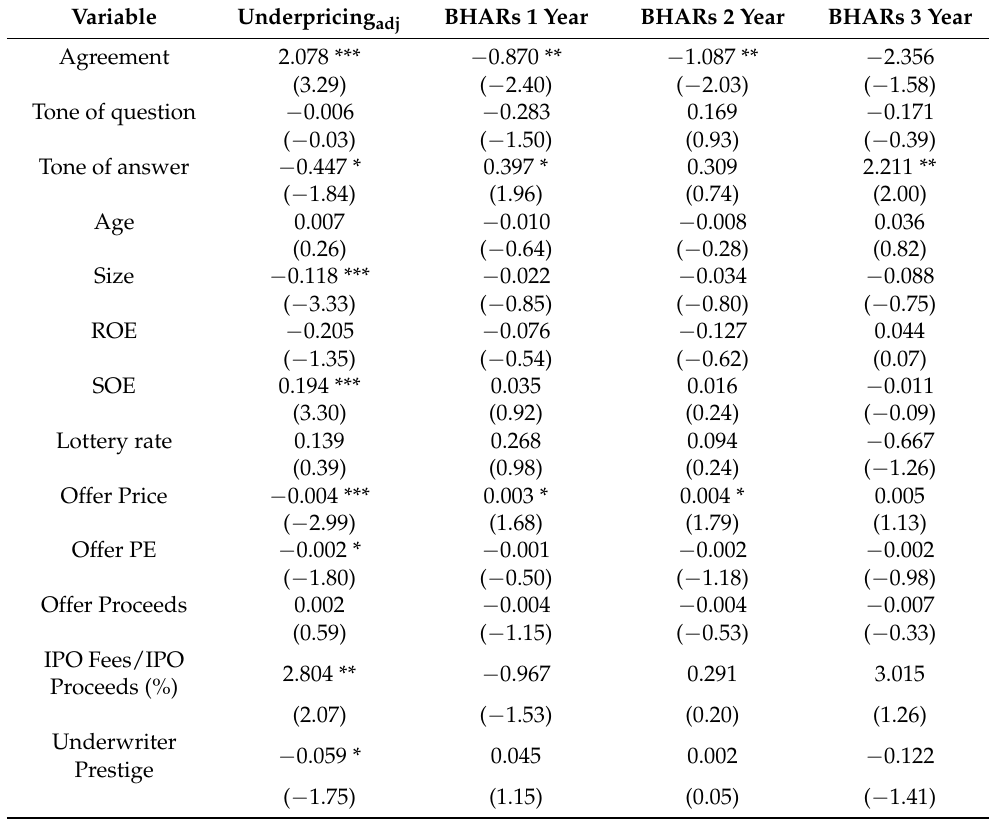
Table 6. Robustness Check: Market Adjusted Underpricing and